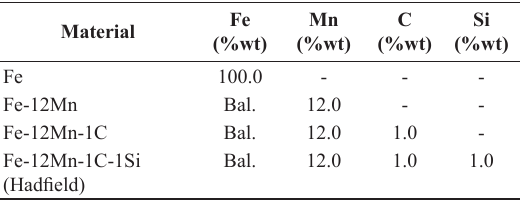
Table 1. Chemical composition of the mixtures produced in the study. Material